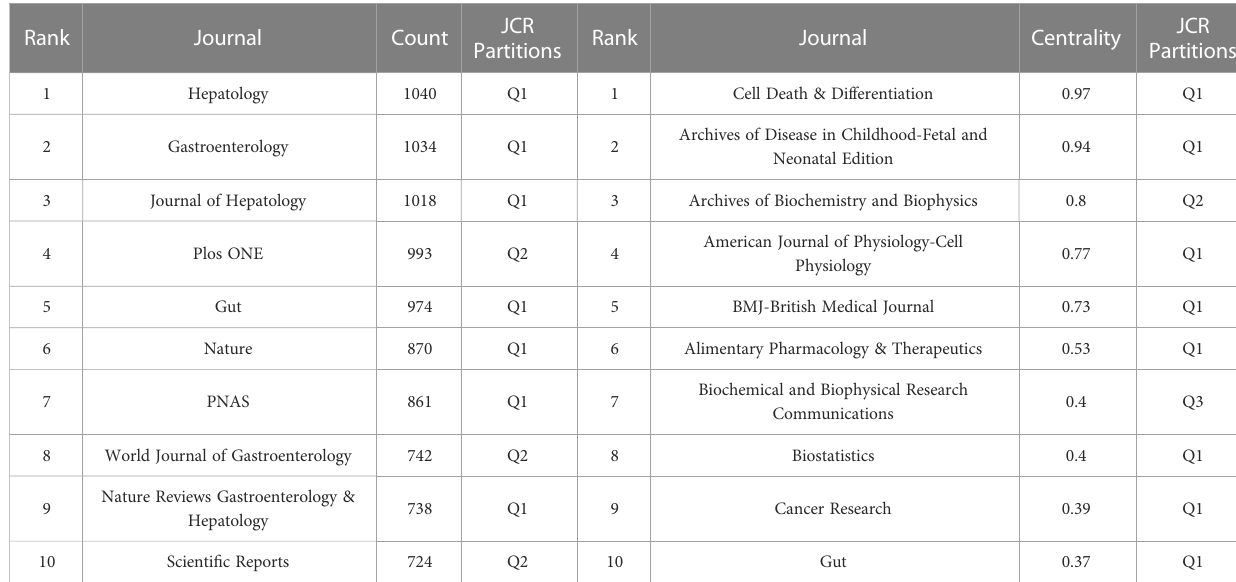
TABLE 5 Top 10 journals for co-citation of the gut-liver axis in